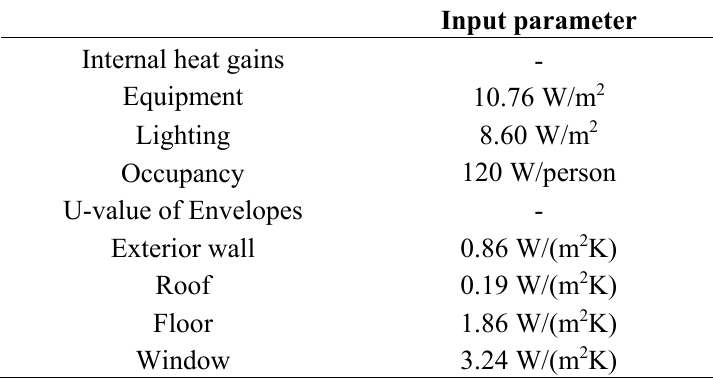
Table 4. Specifications of the reference office building in EnergyPlus.